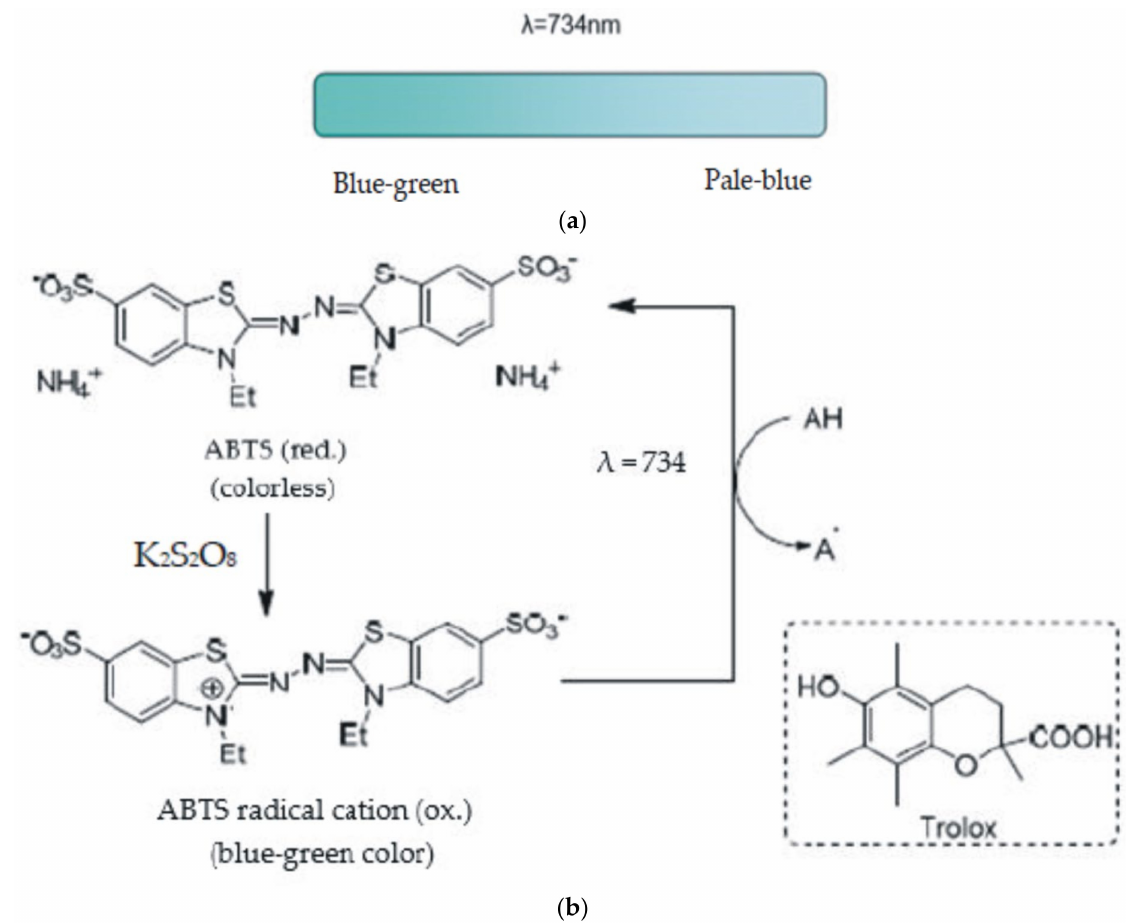
Figure 9. Colour variation in ABTS assay ( a ); Reaction scheme involved in 2,2 (cid:48) -Azinobis-(3-ethylbenzothiazoline-6-sulfonic acid (ABTS) radical cation scavenging activity assay ( b